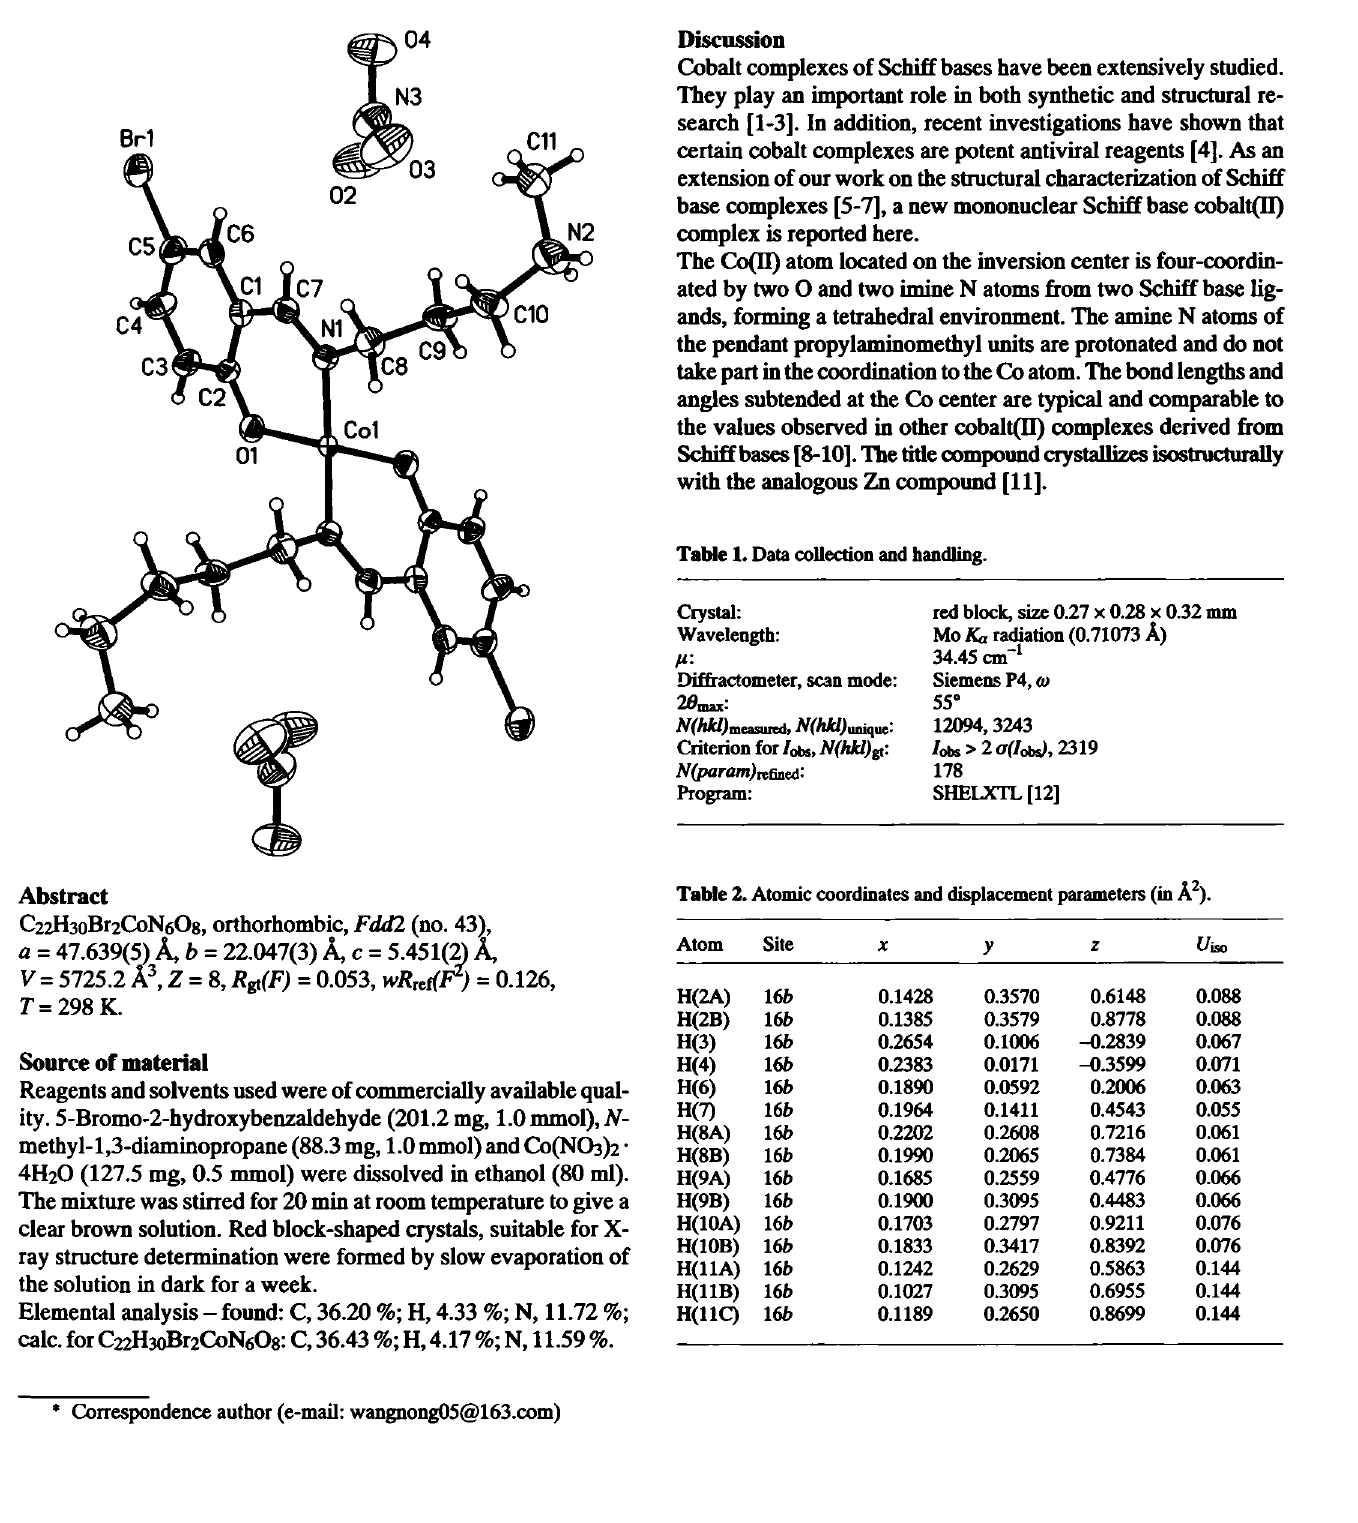
Table 2. Atomic coordinates and displacement parameters (in A 2